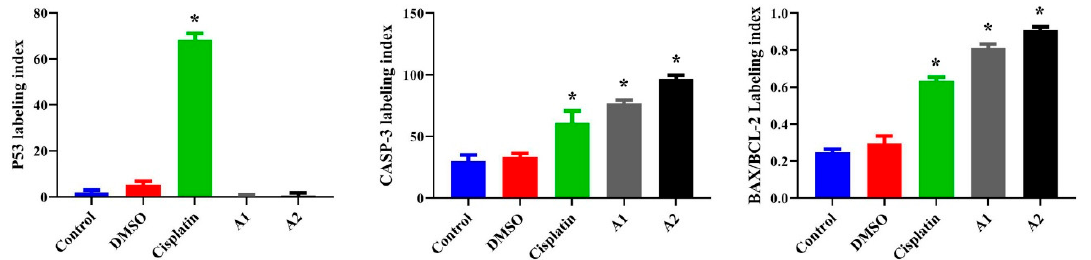
Figure 8. The percentage of immunocytochemical positive AML cells in control and treated groups after 3 h of incubation. Data represent the average of three independent experiments for the protein expression of p53, CASP-3 and BAX/BCL-2 ratio (n = 3). Bars: standard deviation; *: significant with respect to the control ( p < 0.05). CASP-3: Caspase-3; A1: A. hierochuntica methanolic extract (0.5 µ g/mL); A2: (3.0 µ g/mL); cisplatin: (3.0 µ g/mL).